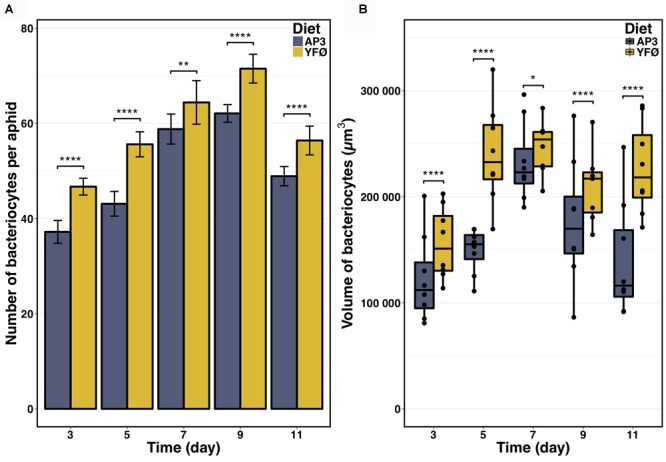
Impact of the tyrosine and phenylalanine depleted diet on aphid bacteriocytes. (A) Number of bacteriocytes per aphid. Results are reported as means (±SD) of 10 isolated individuals per diet. Data were analyzed using Welch’s t-test and significant differences are indicated with asterisks (∗∗P ≤ 0.01, ∗∗∗∗P ≤ 0.0001). (B) Volume of bacteriocytes. Results are displayed as box plots where central lines represent the medians, boxes comprise the 25–75 percentiles and whiskers denote the range; n > 7 aphids per time point, for a total number of more than 2 600 bacteriocytes isolated and analyzed. Data were analyzed using Welch’s t-test and significant differences are indicated with asterisks (∗P ≤ 0.05, ∗∗∗∗P ≤ 0.0001).